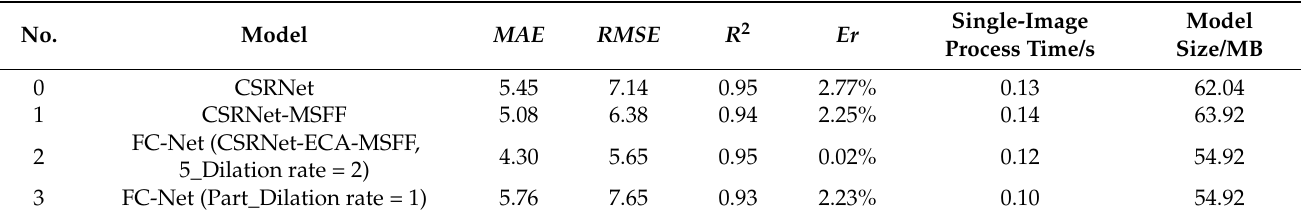
Figure 8. Regression results between predicted number of peach flowers by different models and corresponding true values. ( a ) CSRNet; ( b ) CSRNet-MSFF; ( c ) FC-Net (CSRNet-ECA-MSFF, 5_Dilation = 2); ( d ) FC-Net (Part_Dilation = 1). Table 2. Peach flower counting performance of different networks based on